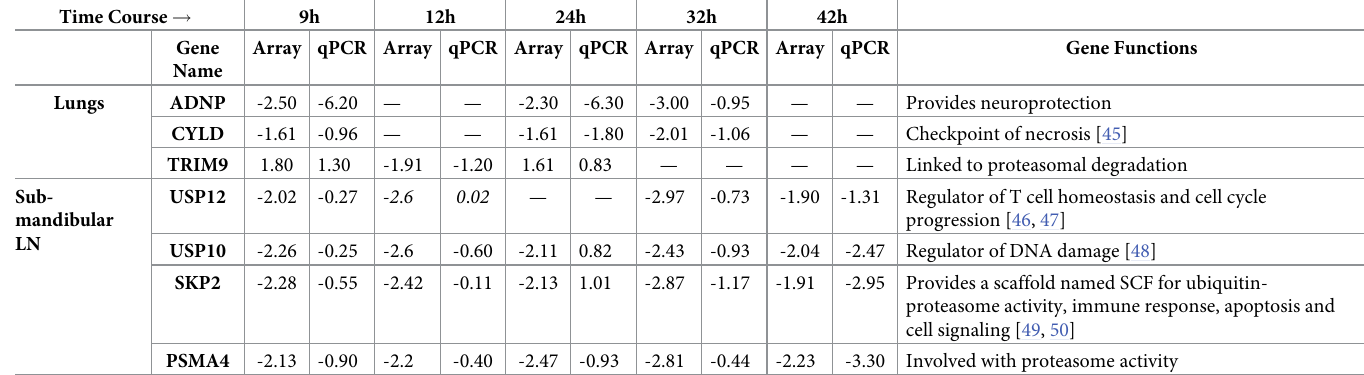
Table 1. The list of genes assayed for validation using QuantiGene Plex platform. The high throughput array data and BioPlex/qPCR data are presented in a log 2 (fold change).Those instances, where the regulations measured by array and qPCR results are in opposite directions were in italics. S6 Fig depicts the bar plots of qPCR results. Time Course